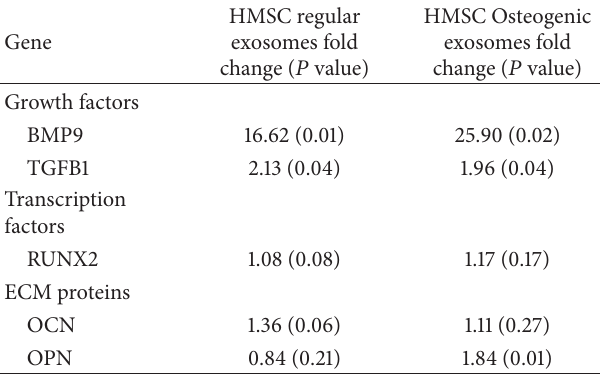
Table 3: Four-week exosome mediated change in gene expression: 2D HMSC